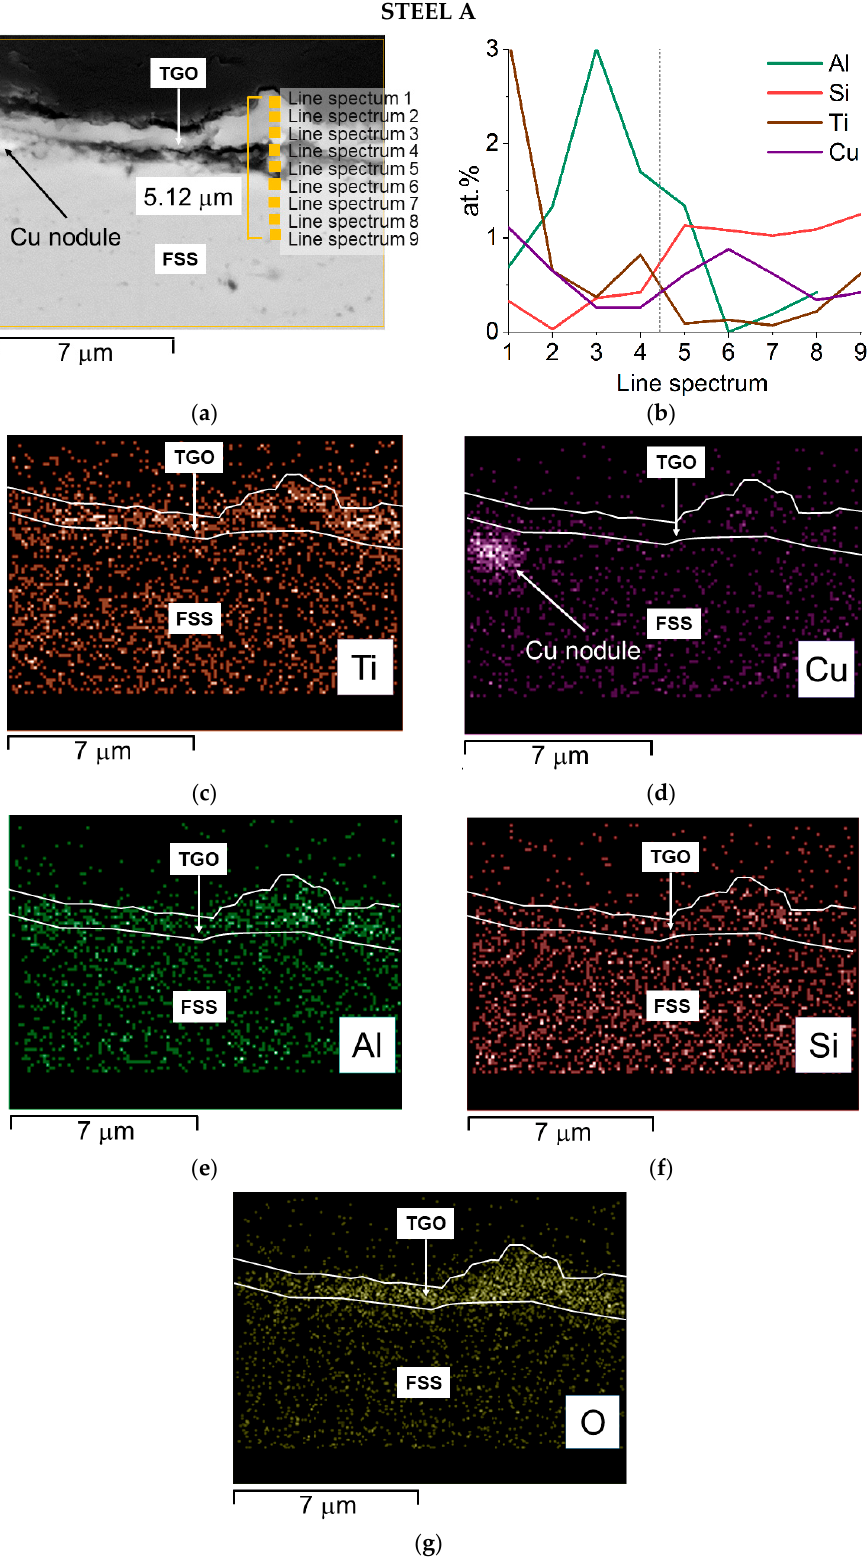
Figure 10. Steel A—SEM-SE micrograph of the oxide scale with spots and area of EDS analyses, 20,000 × ( a ) EDS quantitative profile ( b ) and EDS elemental maps ( c – g